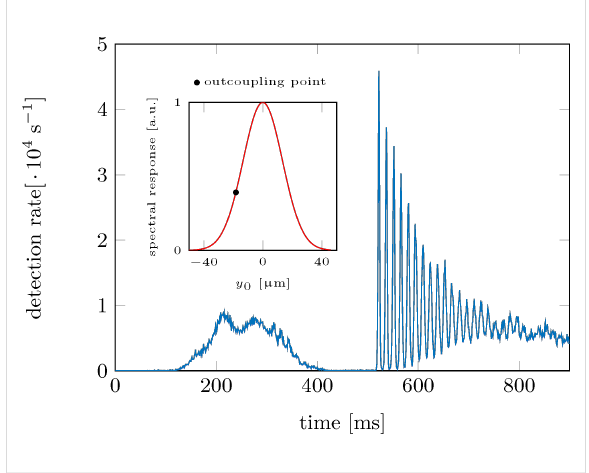
Figure 8: Ion signal during and after the excitation of the cold-atom tip to a center-of-mass